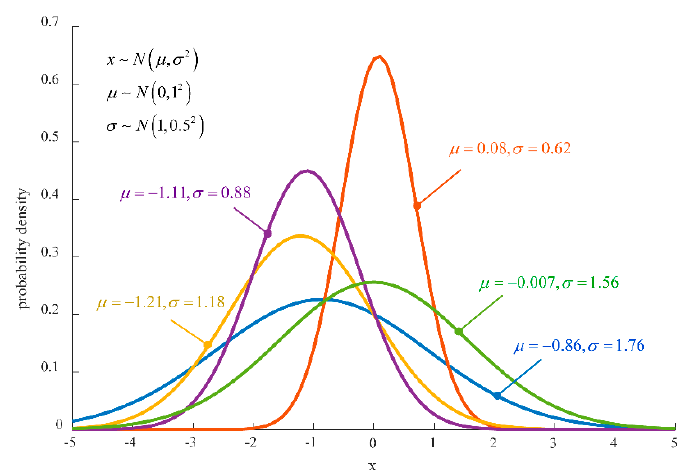
Figure 4. Family of PDFs for a single variable.